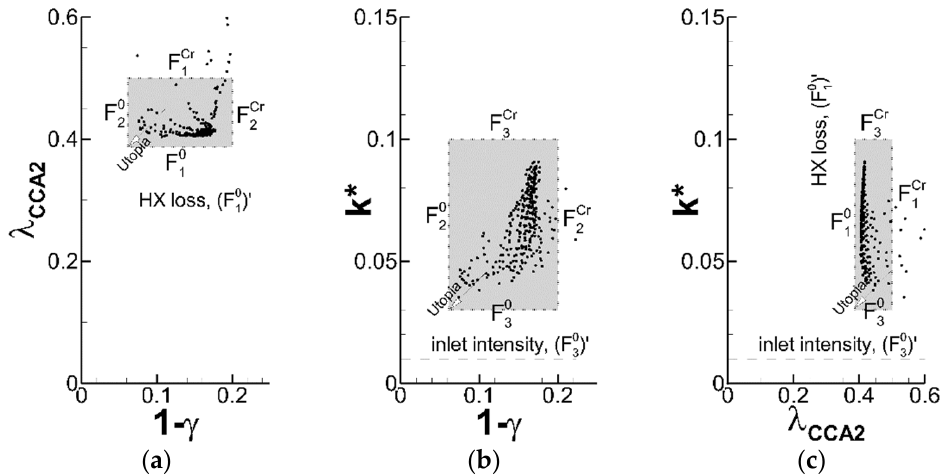
Figure 23. DoE 3 results—Projected 3D criterion space into three individual 2D components ( a – c